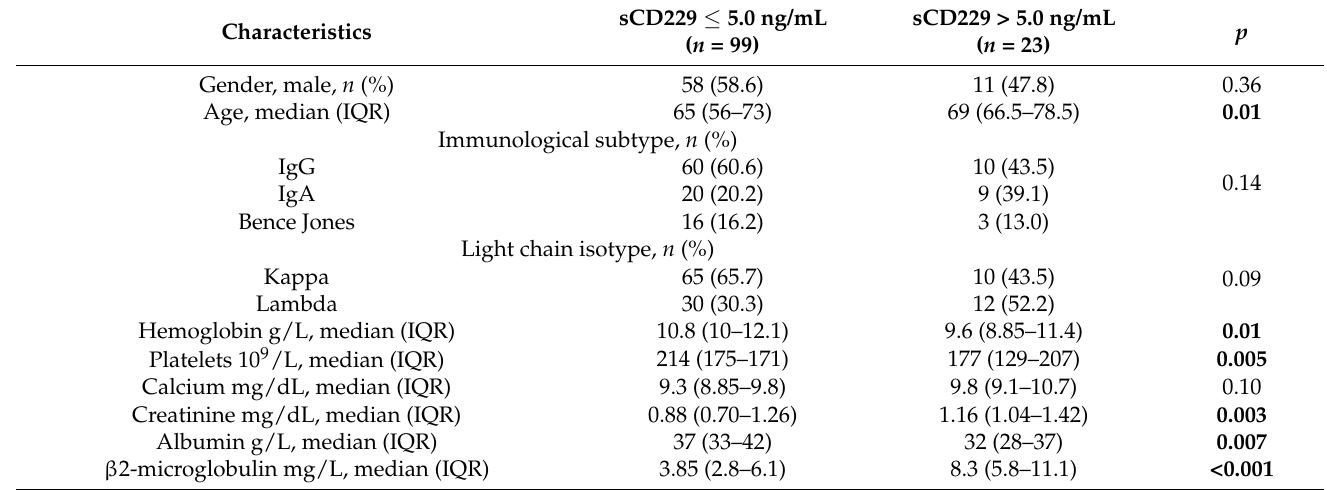
Table 2. Clinical features of the patients with MM according to the sCD229